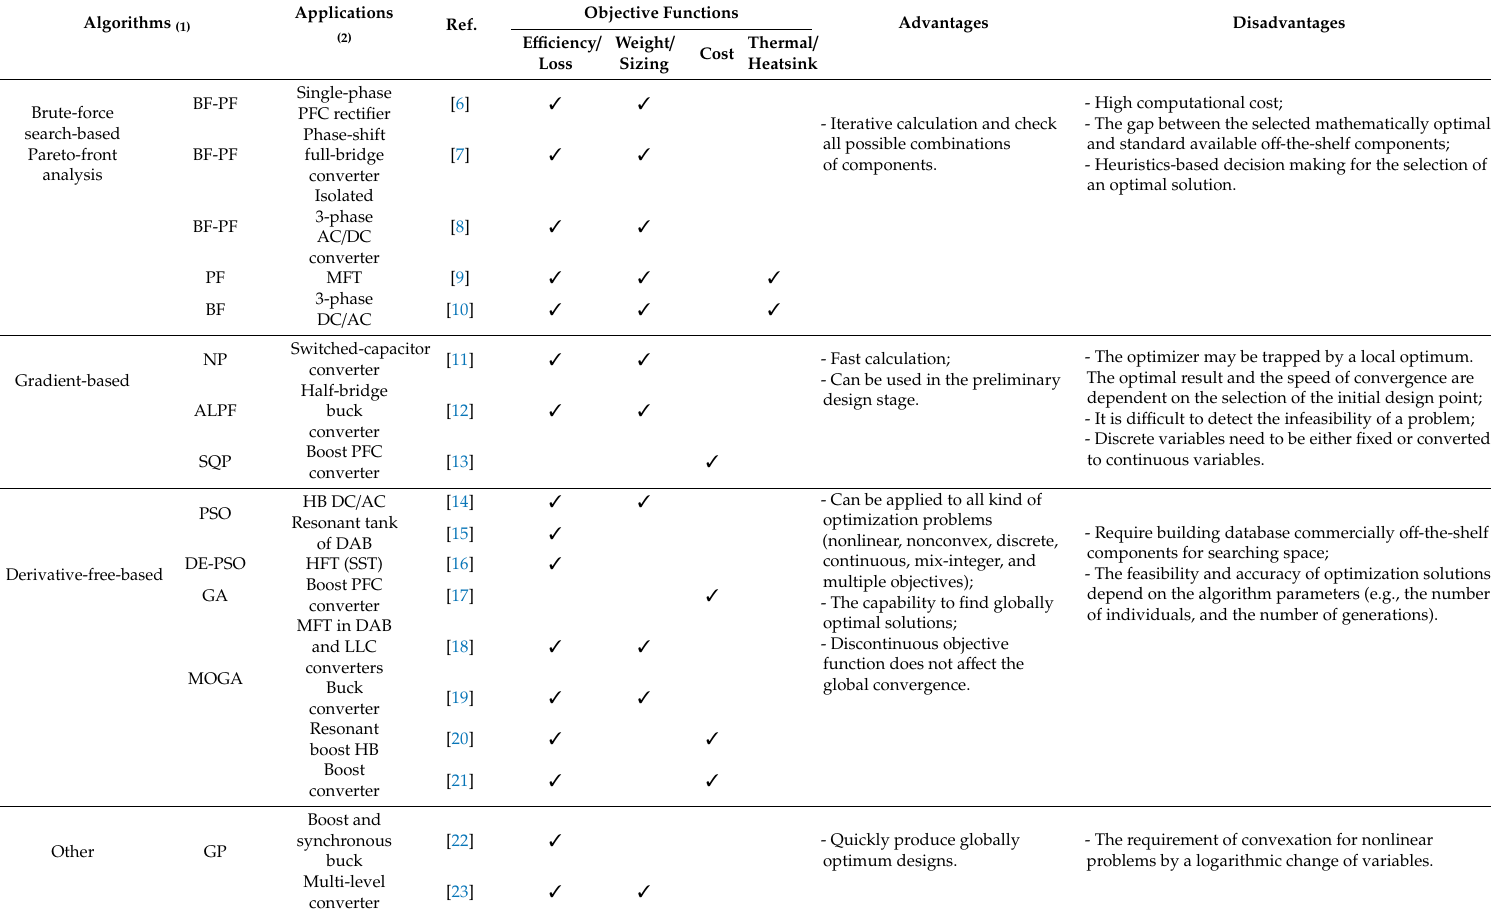
Table 1. Summary of optimization algorithms for the power electronics converters.